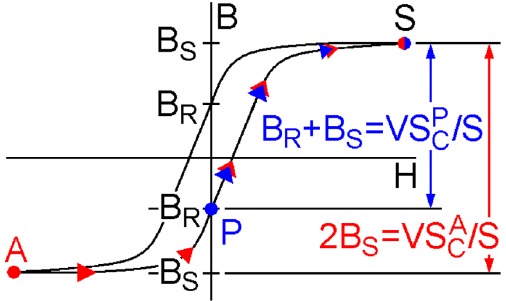
FIG. 13. (Color) Variation of the core induction depending on the LTD firing time relative to the premagnetizing pulse. Blue arrows describe the core behavior if the LTD stage is fired later than the end of the PPG pulse (passive premagnetizing), while the red arrows present the case where the LTD is fired at peak PPG current (active